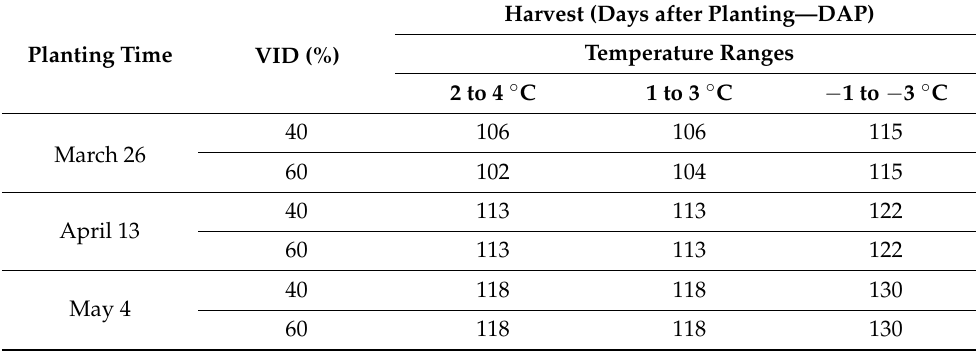
Table 1. Cycle of garlic crop (days) under different temperatures ranges and visual index of overcom- ing dormancy (VID). Harvest (Days after Planting—DAP) Temperature Ranges Planting Time VID (%) 2 to 4 ◦ C 1 to 3 ◦ C − 1 to − 3 ◦